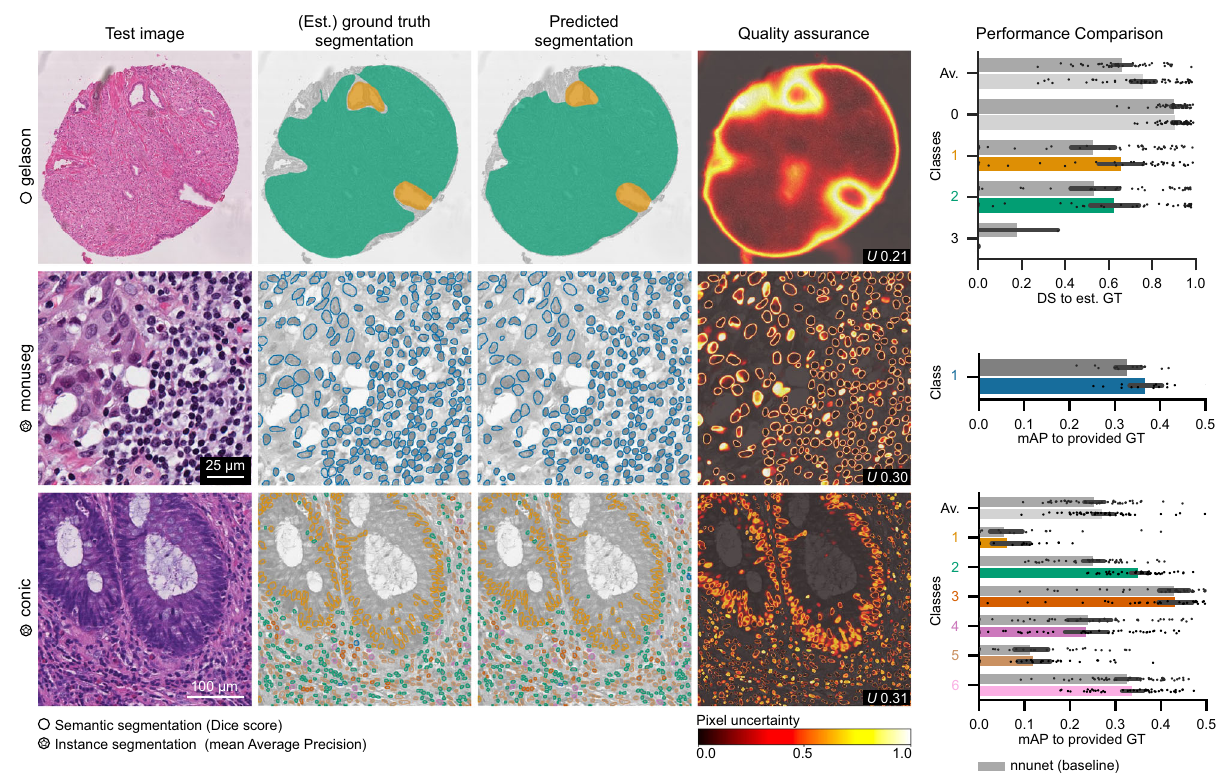
Fig. 6 | Demonstration on challenge datasets gleason , monuseg , conic . Exemp- lary test image slices ( fi rst column), corresponding GT segmentations (second column), predicted segmentations (third column), and uncertainty maps (fourth column) with uncertainty scores U . GT segmentations for the gleason dataset were estimated via STAPLE. The bar plots in the last column summarize the results over theentiretestsetsbyclassforsemanticsegmentation( gleason , N =49testimages)